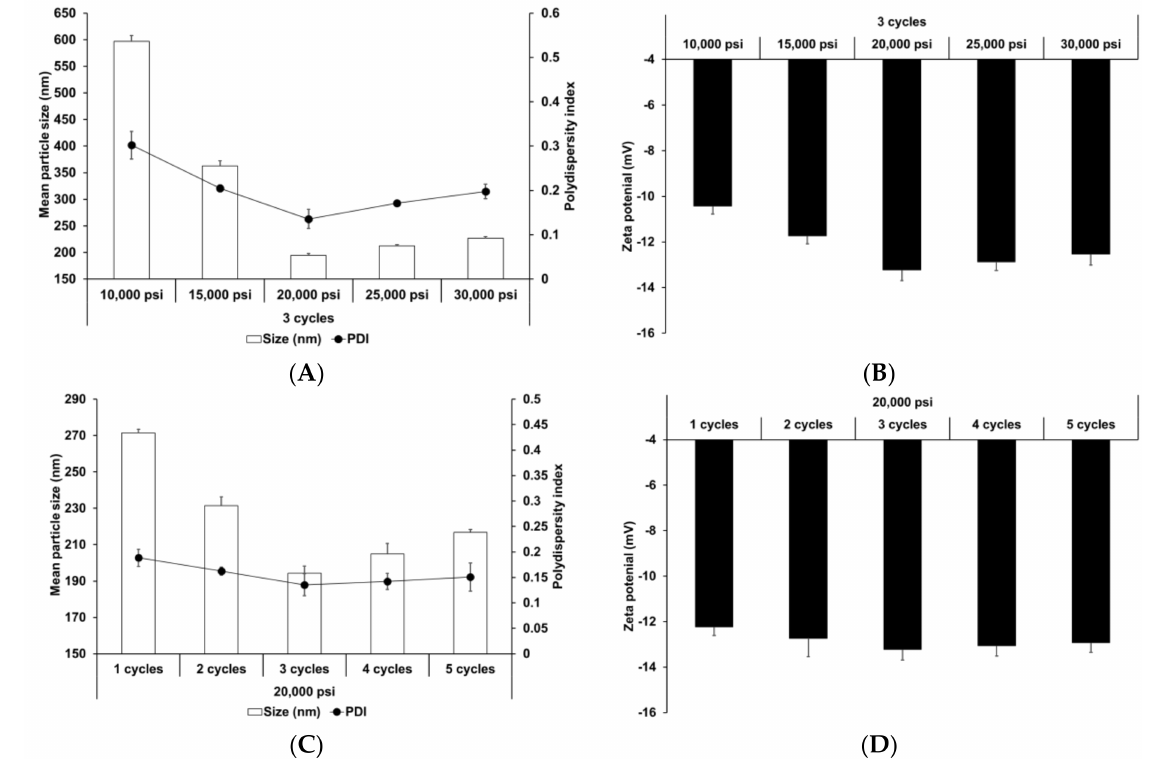
Figure 2. Physicochemical characteristics (average particle size, polydispersity index (PDI), and zeta potential) of adenosine- loaded solid lipid nanoparticles (SLNs). Results are expressed as the means ± standard deviations of three independent experiments ( n = 3). ( A ) Particle size and PDI and ( B ) zeta potential of adenosine-loaded SLNs prepared using different pressures. ( C ) Particle size and PDI and ( D ) zeta potential of adenosine-loaded SLNs prepared using different number of cycles. PDI, polydispersity index; SLNs, solid lipid